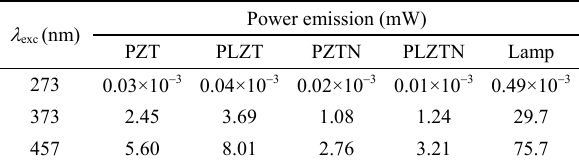
Table 4 Emission power in each PZT system with dopant concentration of 1.0 mol%, excited with 273, 373, and 457 nm; for each excitation band the power incident is also measured. The power shown is the sum of all powers present with that excitation because the detector is not selective in wavelength Power emission (mW)  exc (nm) PZT PLZT PZTN PLZTN Lamp 273